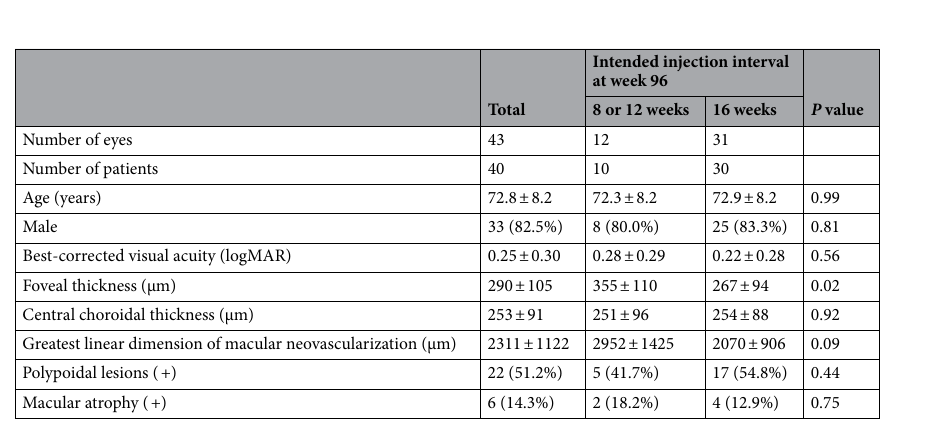
Table 3. Comparison of baseline characteristics between eyes with an 8- or 12-week intended injection interval versus those with a 16-week intended injection interval at week